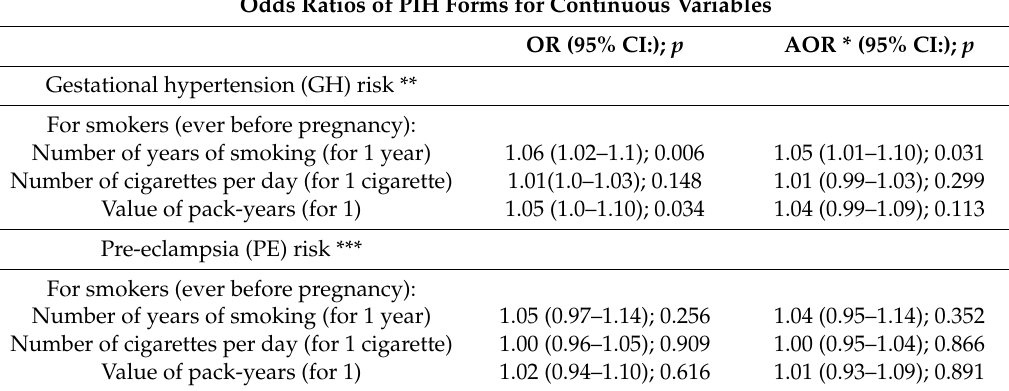
Table 3. Adjusted odds ratios of gestational hypertension (GH) and pre-eclampsia (PE) for additional smoking categories (continuous variables).